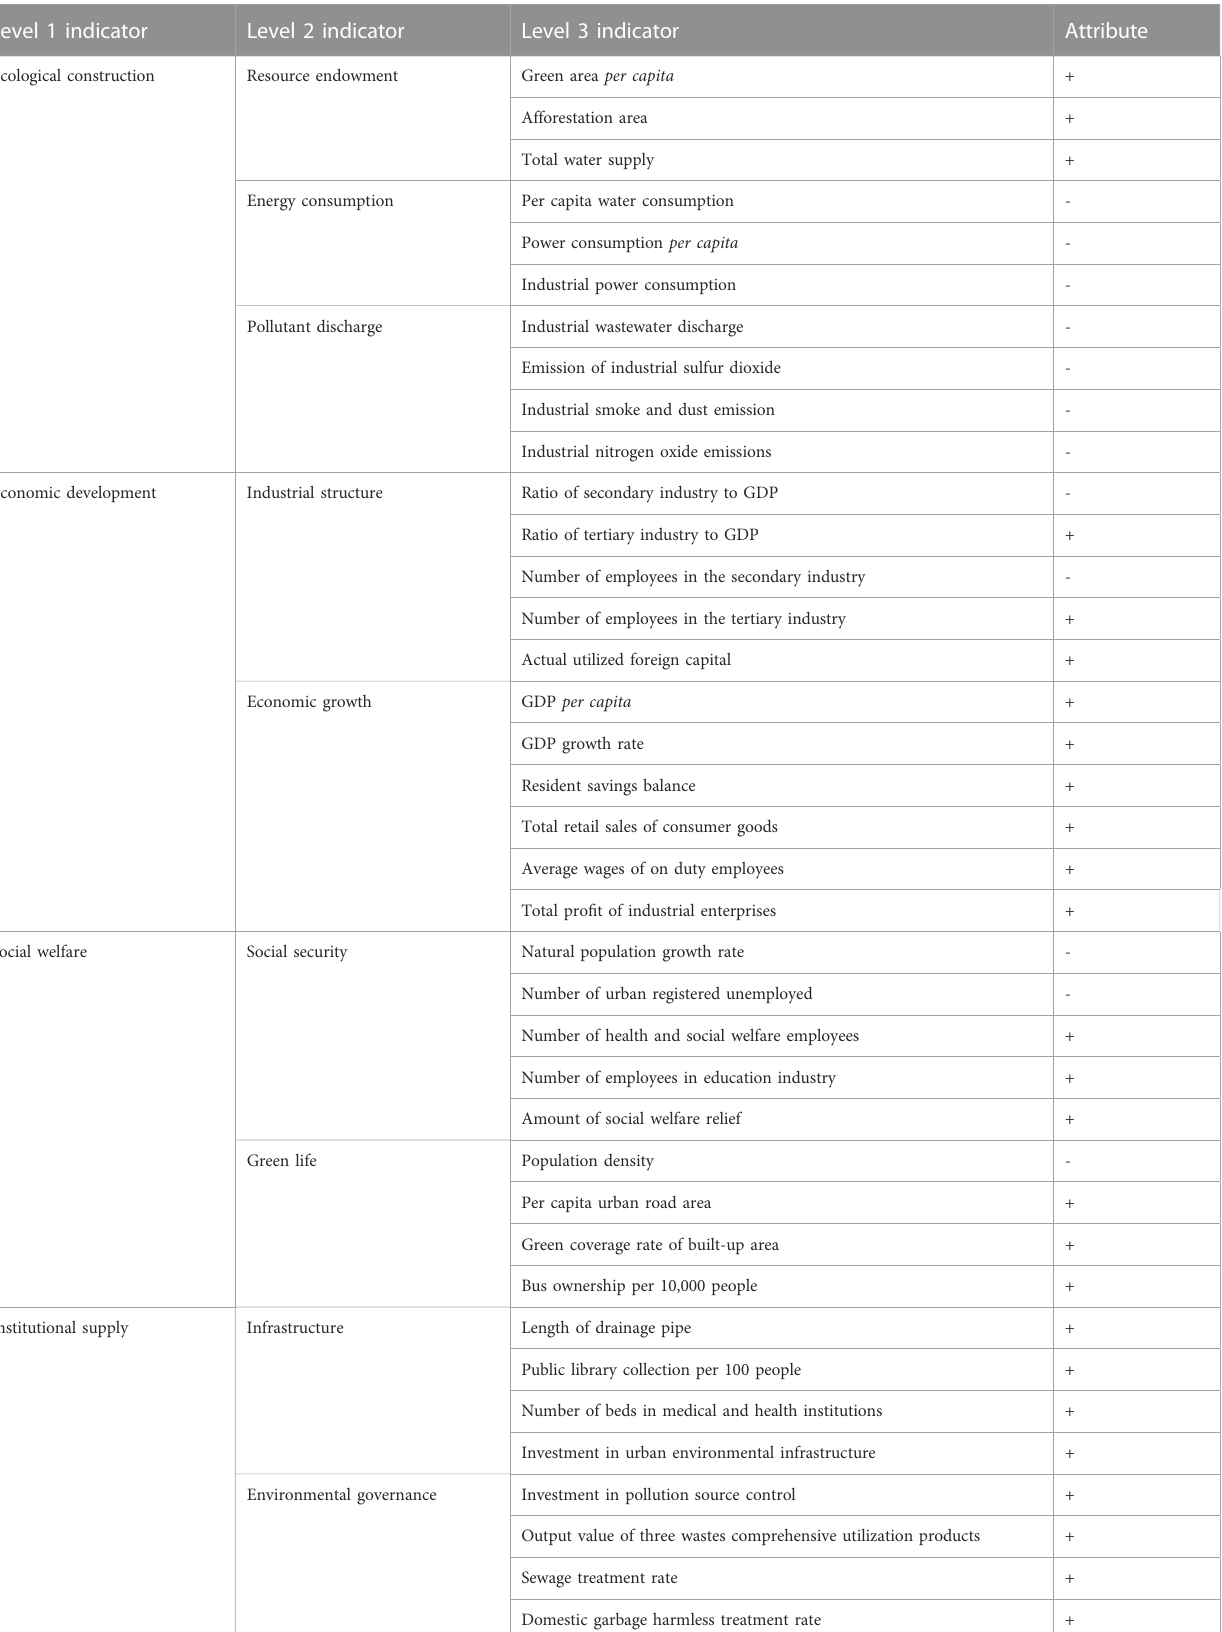
TABLE 1 Green development indicator evaluation